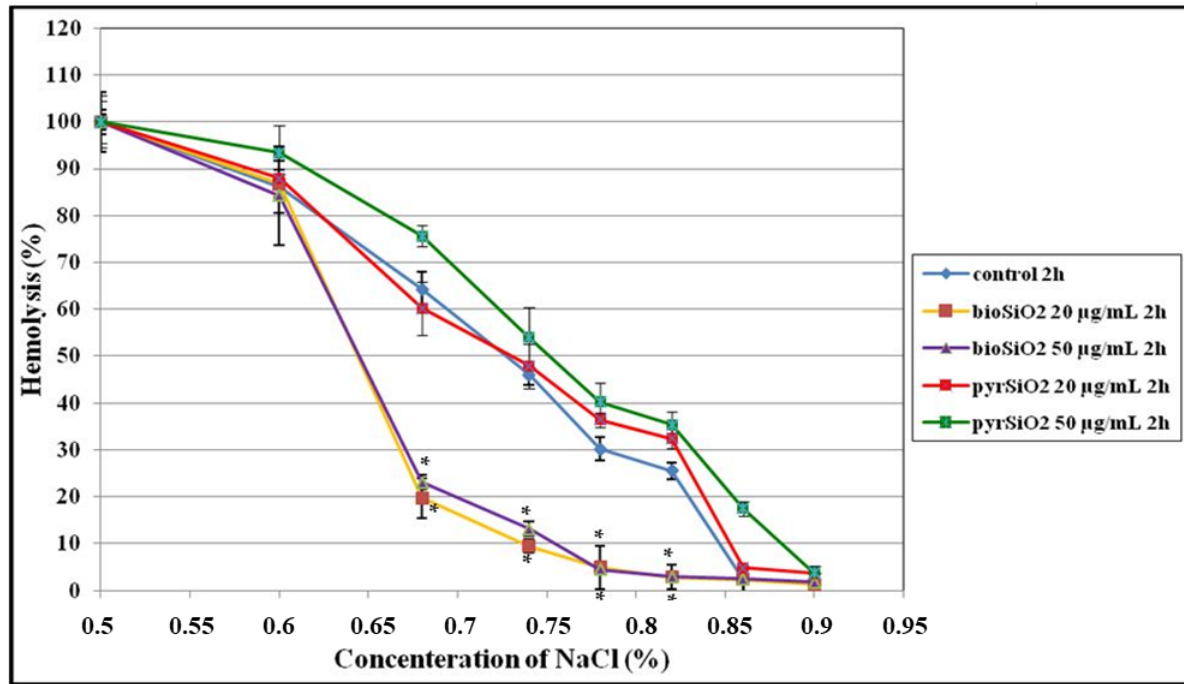
Figure 10. Percentage of hemolysis of erythrocytes. The hemolytic toxicity of bio SiO 2 and pyr SiO 2 nanoparticles concerning red blood cells was analyzed after 2 h and 24 h of incubation. Statistical evaluation of differences was made using the ANOVA I and Tukey’s post hoc test, at significance levels of p < 0.01 (*) with respect to control.